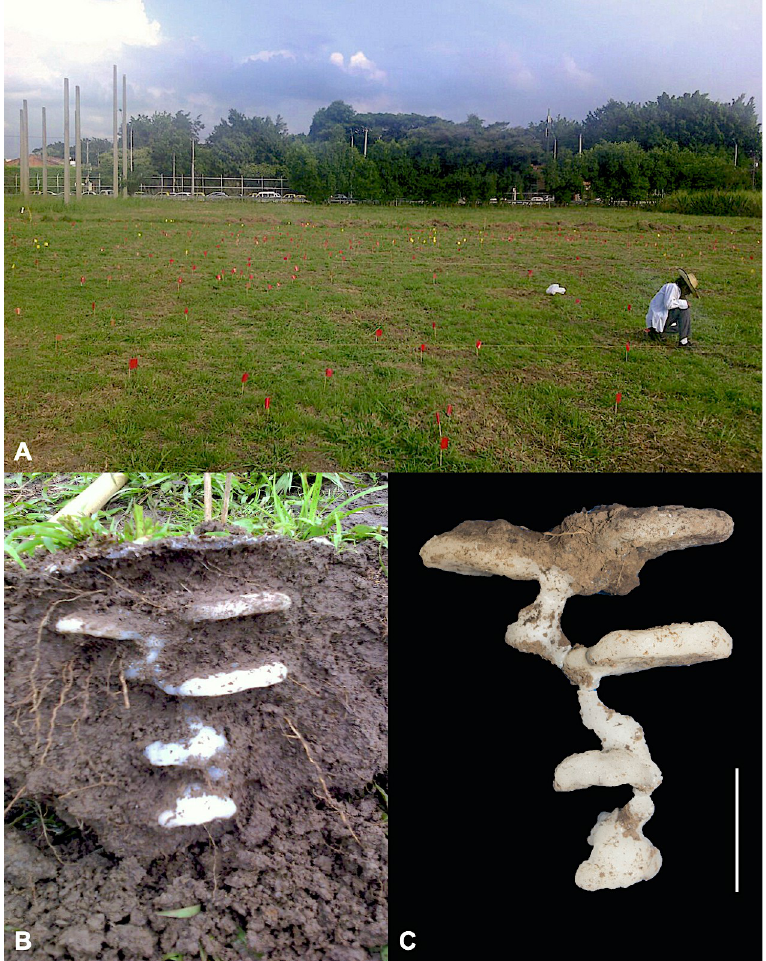
Fig 1. Wax cast nest collection. (A) study area at the Campus of Universidad del Valle, Cali, with the entrances of the nests marked by a flag, (B) wax casting of nest #8 embedded in its natural habitat prior to extraction, (C) the same nest #8 once cleared of its soil matrix; the scale bars correspond to 10 cm. Photos: C.